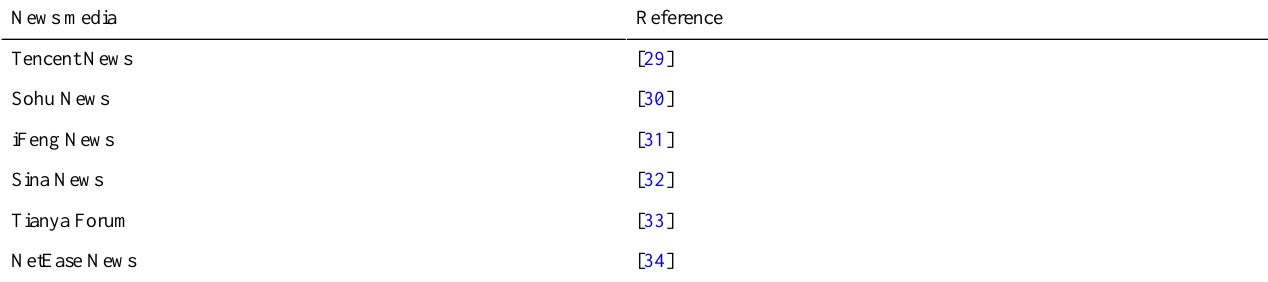
Table 1. All news media used to obtain sample